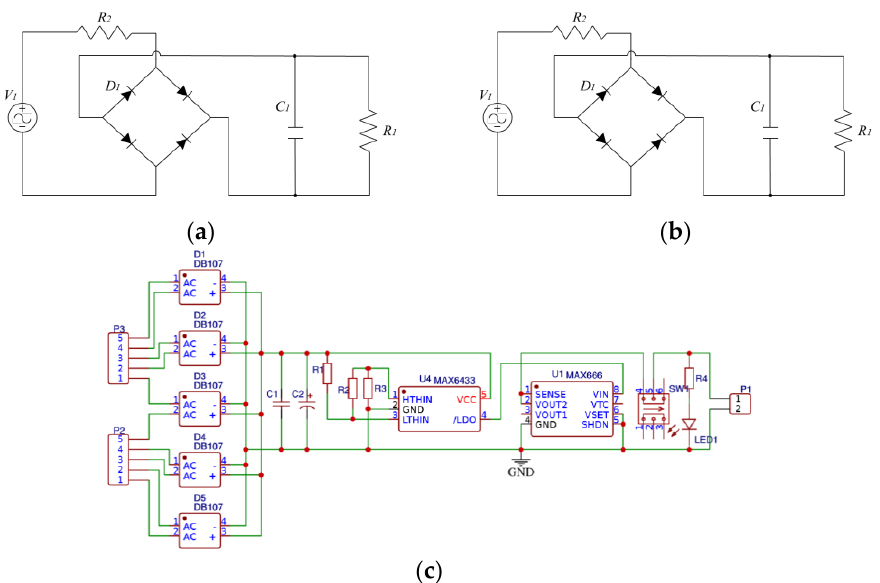
Figure 7. Circuit diagram of the SPEH. ( a ) Traditional energy harvesting circuit. ( b ) Experimental facility. ( c ) Overall rectifier filter energy storage circuit.